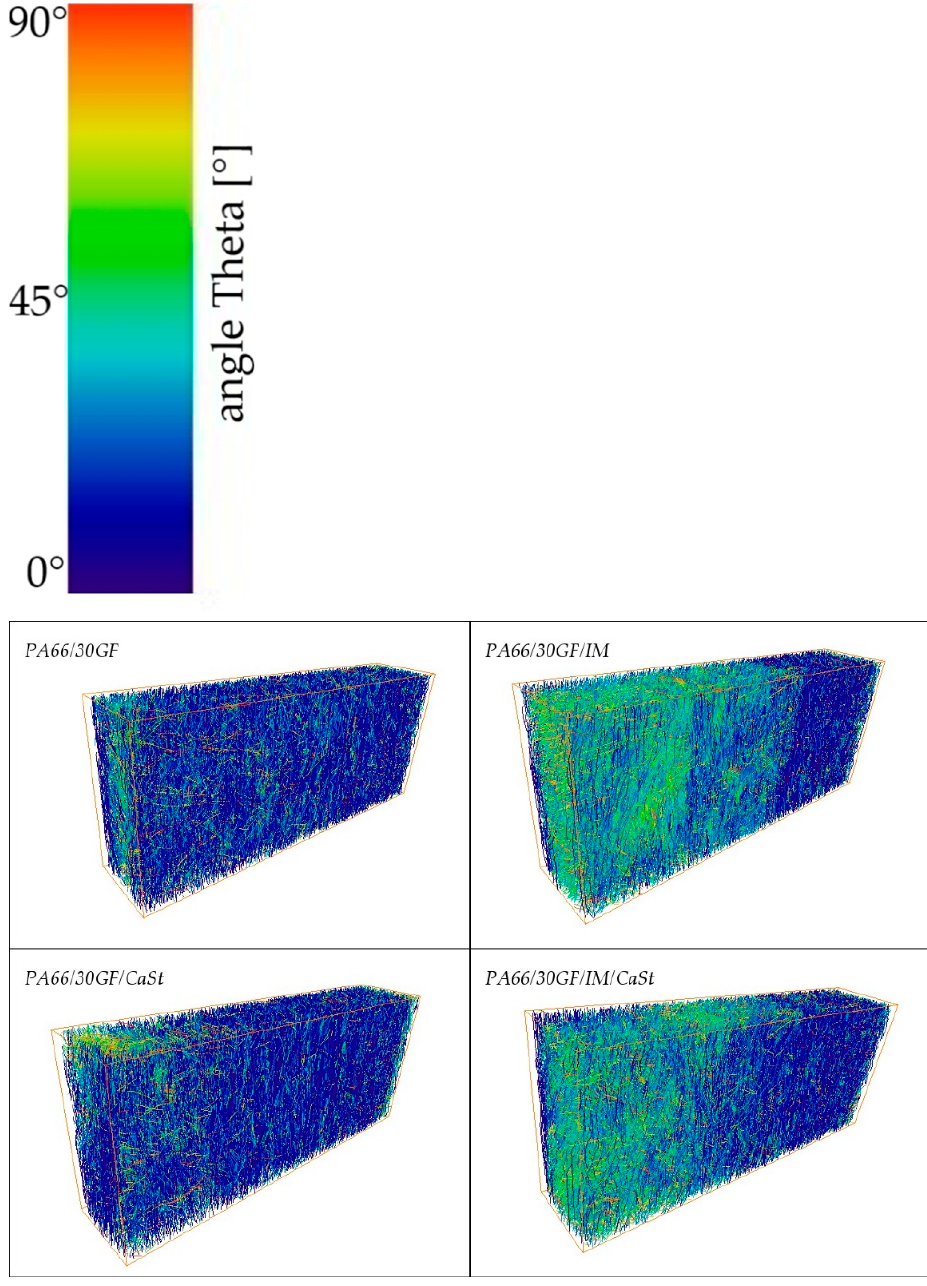
Figure 6. Fiber orientation of di ff erent PA66 compositions